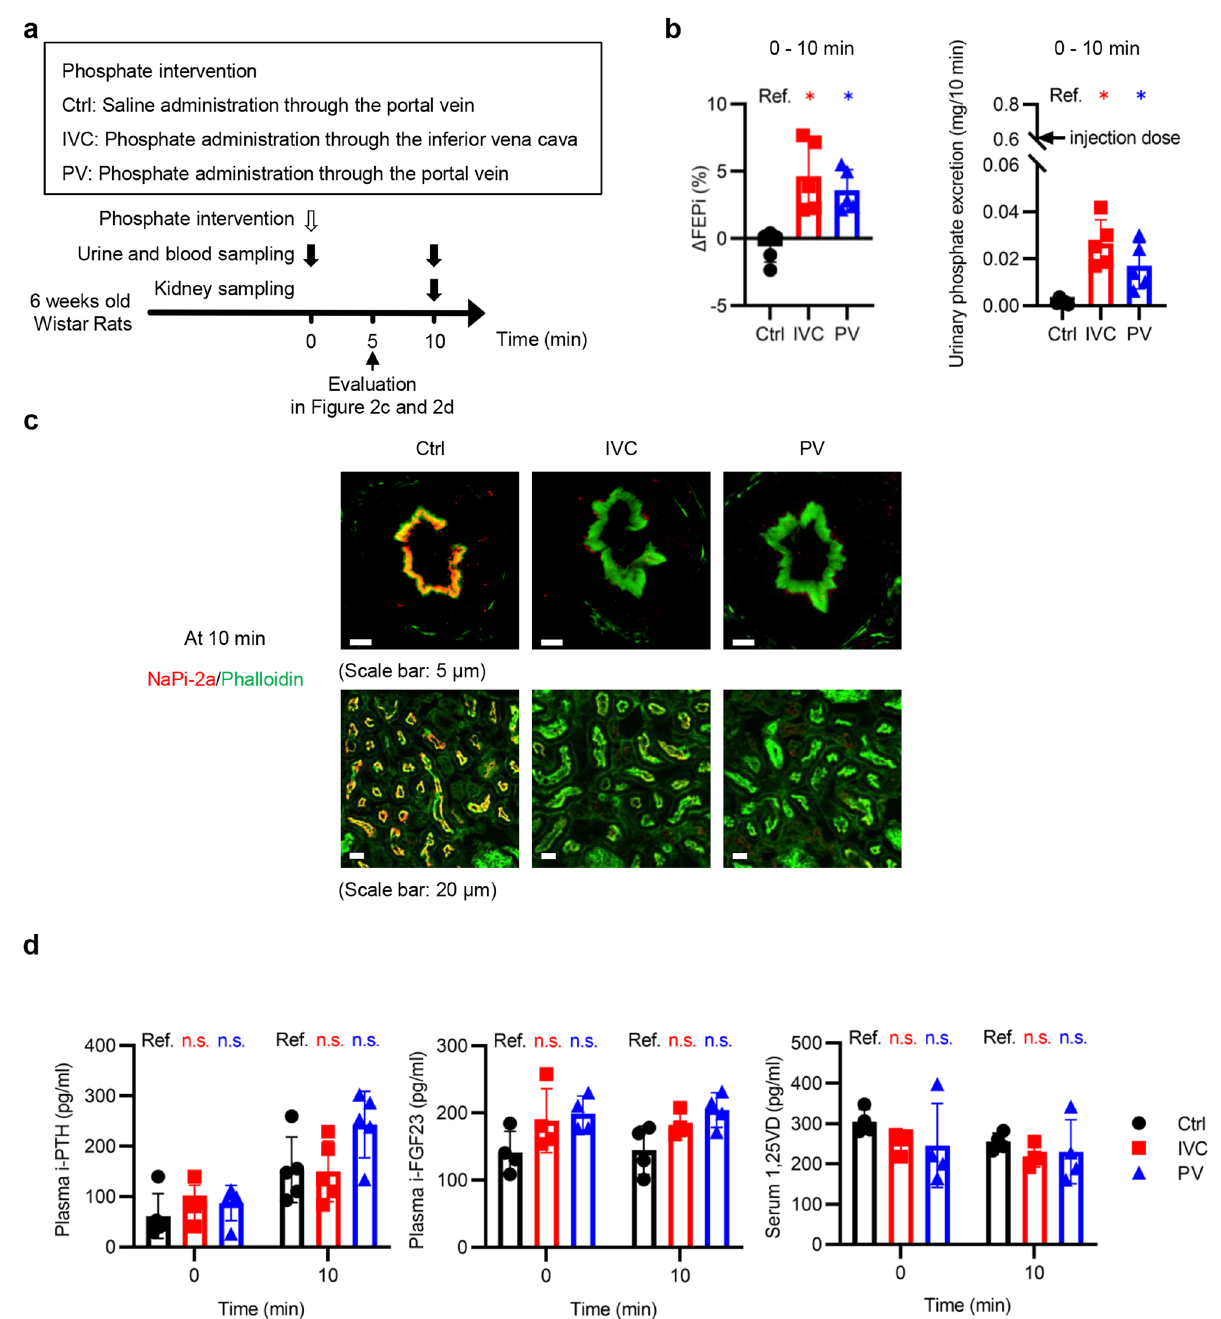
Figure 4. Within 10 min after the phosphate intervention, FEPi and phosphaturia increased in both the PV and CV groups. ( a ) Experimental design of ( b ) to ( d ). The normal rats received phosphate interventions in the same manner as shown in Fig. 2a. The rats at 5 min after the phosphate interventions were evaluated in Fig. 2c,d, while rats at 10 min were evaluated in Fig. 4. ( b ) ΔFEPi between 0 and 10 min and urinary phosphate excretion during the 10-min period (n = 5 rats per group). ( c ) Representative immunofluorescence images of renal PTECs stained with phalloidin (green) and NaPi-2a (red) at 10 min. The upper and the lower images in each group are the immunofluorescence images with higher and lower magnifications, respectively (scale bars: 5 µm or 20 µm). ( d ) Plasma intact-parathyroid hormone (i-PTH), intact-fibroblast growth factor 23 (i-FGF23), and serum 1,25-dihydroxyvitamin D (1,25VD) concentrations at 0 and 10 min (n = 4–5 rats per group). Plasma and serum samples were collected from the inferior vena cava. The results are presented as the means ± SDs, n.s.: not significant, Ref.: reference. * P < 0.05 based on Dunnett’s test in ( b ) and ( d